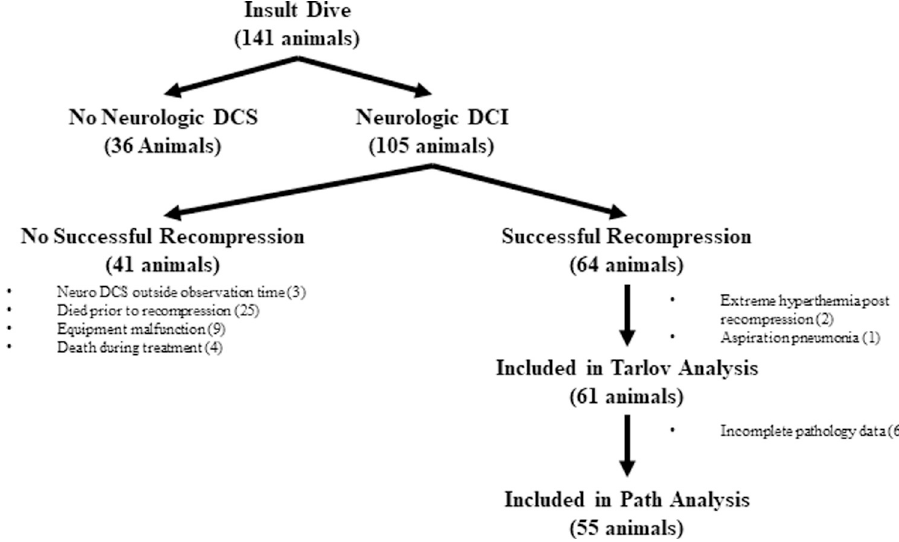
Fig 2. A flow diagram showing the animals included in the final statistical analyses and the reasons for animal